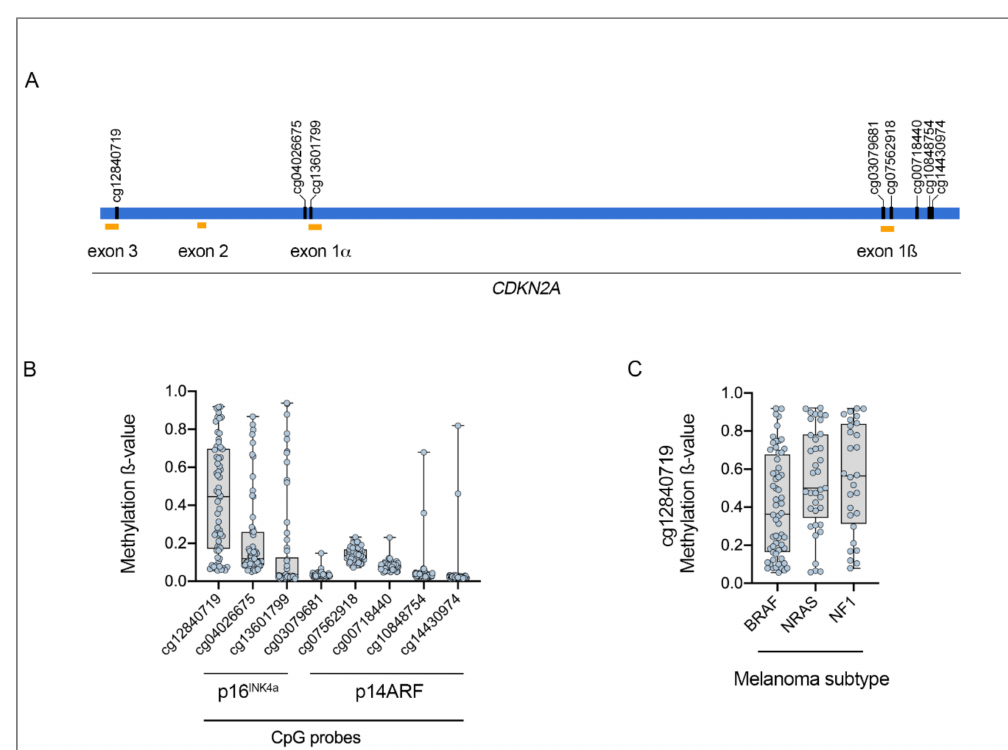
Figure 1. CDKN2A methylation (HumanMethylation450 arrays) ß-values ( β -values range from 0, unmethylated, to 1, fully methylated). ( A ) Location of methylation probes and exons across the CDKN2A locus. ( B ) Methylation status of probes located across the CDKN2A locus. ( C ) Methylation of the cg12840719 probe according to the melanoma genomic subtypes. Data are derived from The Cancer Genome Atlas (TCGA) Skin Cutaneous Melanoma (SKCM) dataset, and only include 62 melanoma tumors without CDKN2A genomic